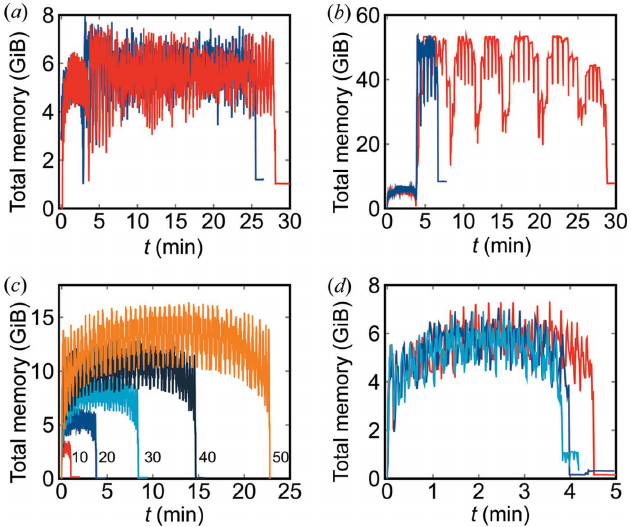
Figure 4 Memory footprint of MatFRAIA . ( a ) Memory footprint during integra- tion and indexing on the laptop over ethernet (red) and from an HDD (blue). ( b ) Memory footprint during integration and indexing on a workstation over ethernet (red) and from a RAM-disk (blue). ( c ) Memory footprint during indexing with different pixel splittings. ( d ) Memory footprint during indexing with a different number of azimuthal bins N ab = [1, 18, 360] for a pixel-splitting level of S = 20.